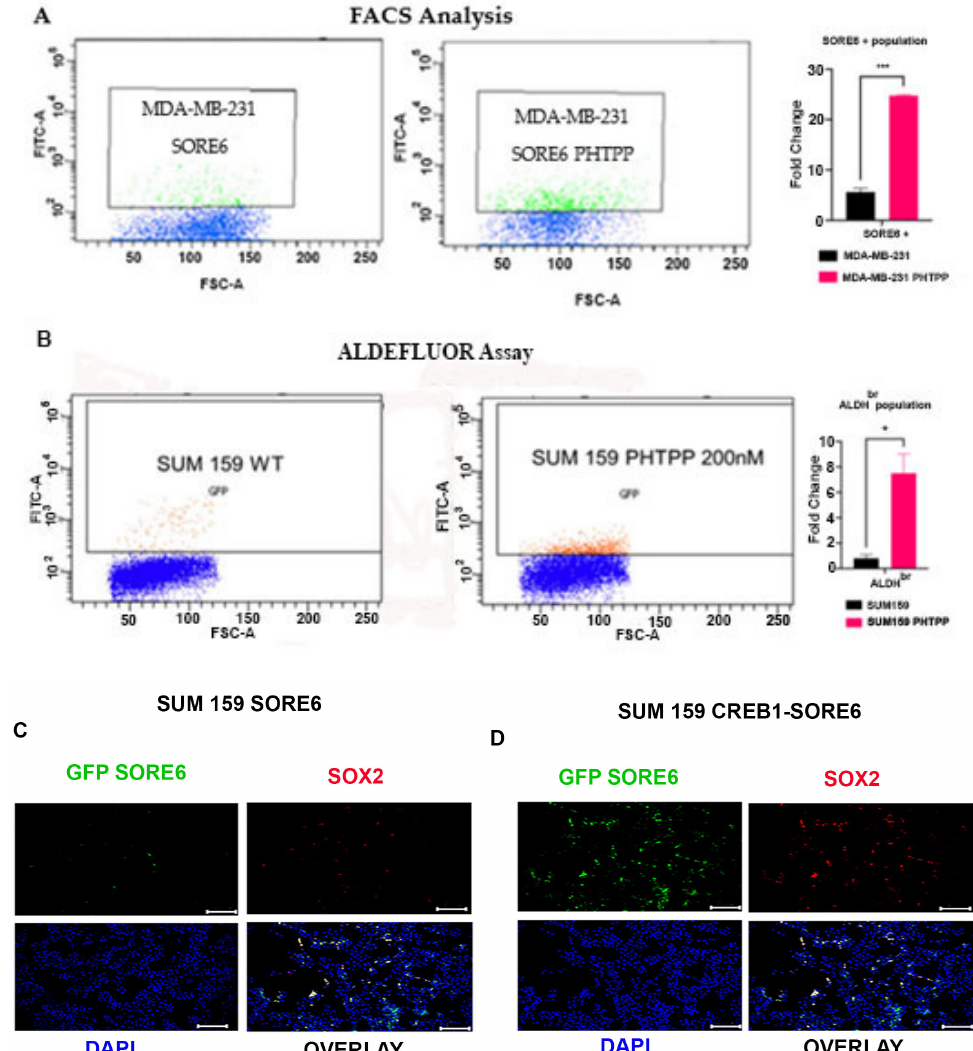
Figure 5. ( A ). MDA-MB-231 cells with integrated SORE6-GFP cancer stem cell reporter was treated with vehicle or 200 nM PHTPP for 48 h and then subjected to FACS analysis. The fold change is based on three technical replicates, and *** p < 0.001. ( B ). SUM159 cells were treated with vehicle or 200 nM PHTPP for 48 h and then subjected to ALDEFLUOR assay, followed by FACS analysis. The fold change is based on three technical replicates, and * p < 0.05. ( C , D ). WT and CRERB1 SUM159 cells with integrated SORE6-GFP reporter were analyzed using GFP for activation of SORE6, and Immunofluorescence for SOX2 scale bars are 200 μ m.